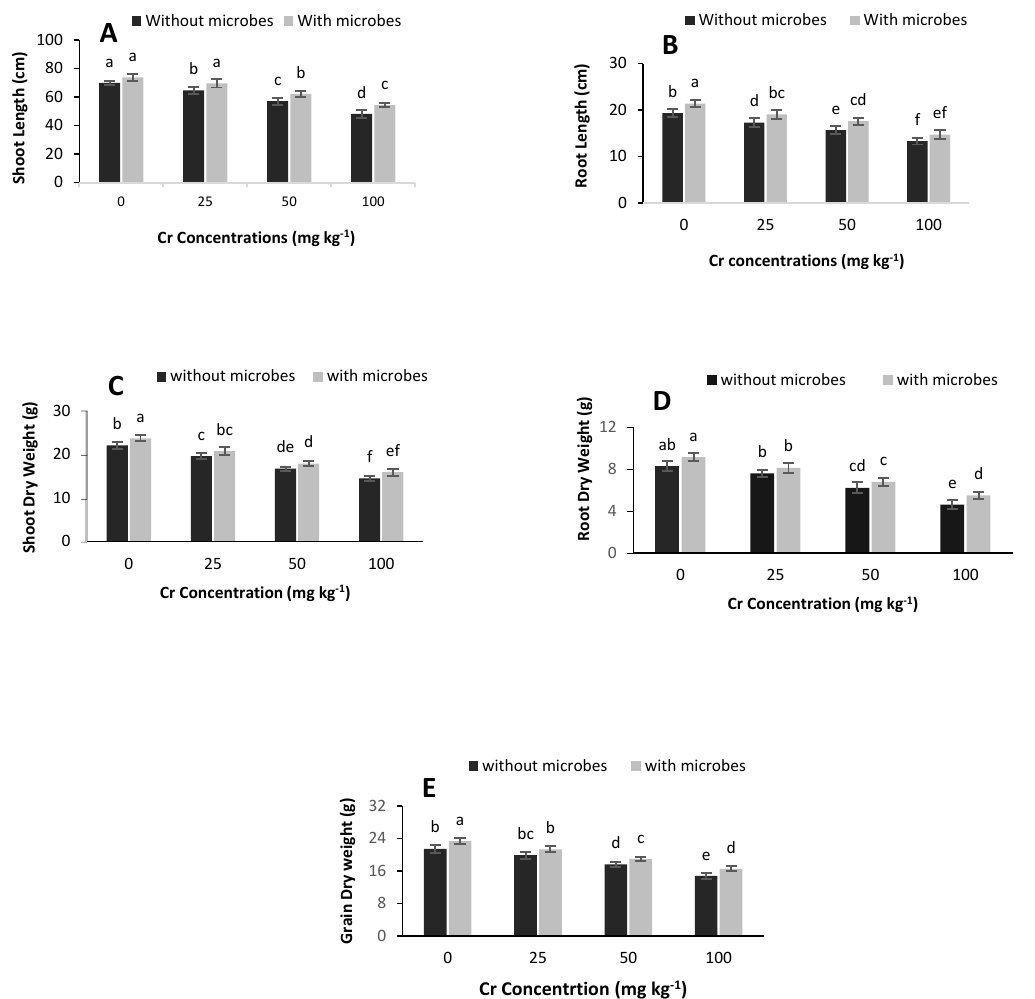
Figure 2. Influence of the di ff erent Cr levels (0, 25, 50, 100 mg · kg − 1 ), with and without peat-moss-based microbial inoculation, on length of shoot ( A ) and root ( B ), dry weight of shoot ( C ) and root ( D ) and grain dry weight ( E ) of wheat. Bars indicate the mean of three replicates with standard deviation (SD). Different bars with lowercase letters show noteworthy changes among various treatments at p < 0.05.